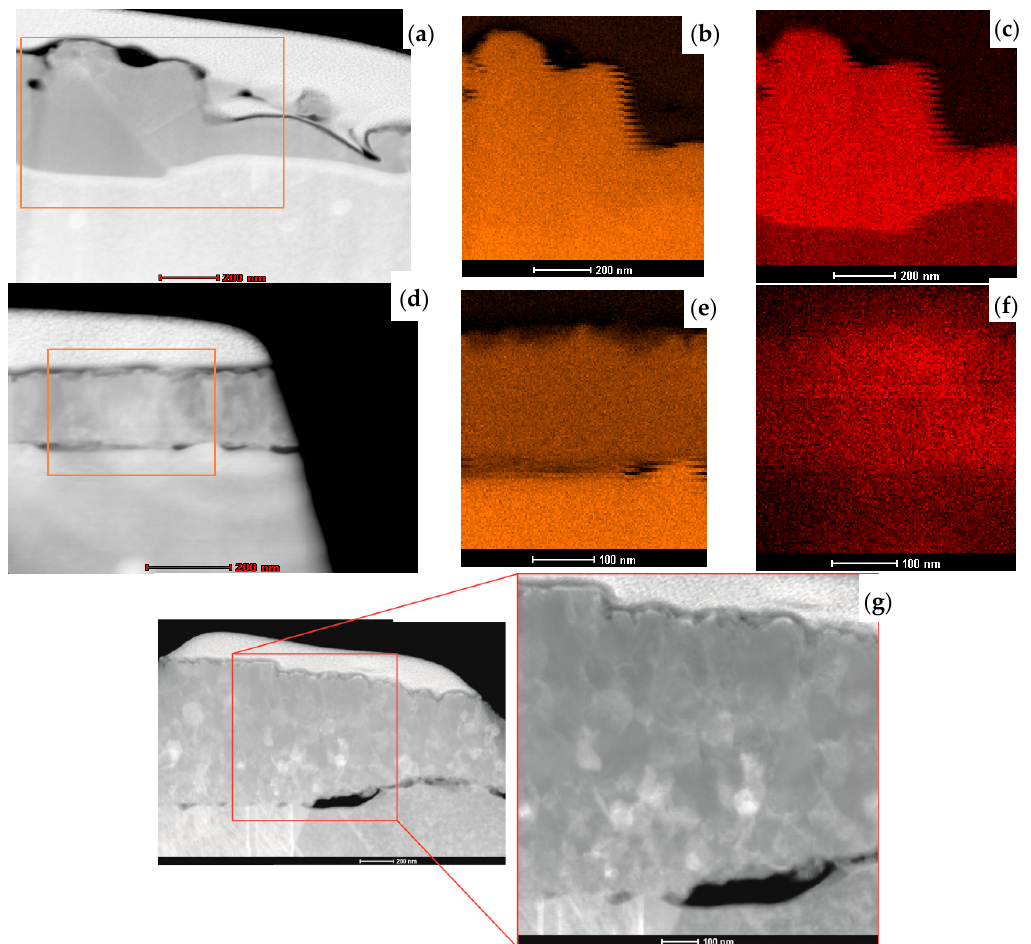
Figure 7. STEM cross-section images of samples ( a ) L1-1, ( d ) L2-4, and ( g ) L3-1 and element distribution maps of copper and oxygen in L1-1 ( b , c ) and L2-4 ( e , f ).